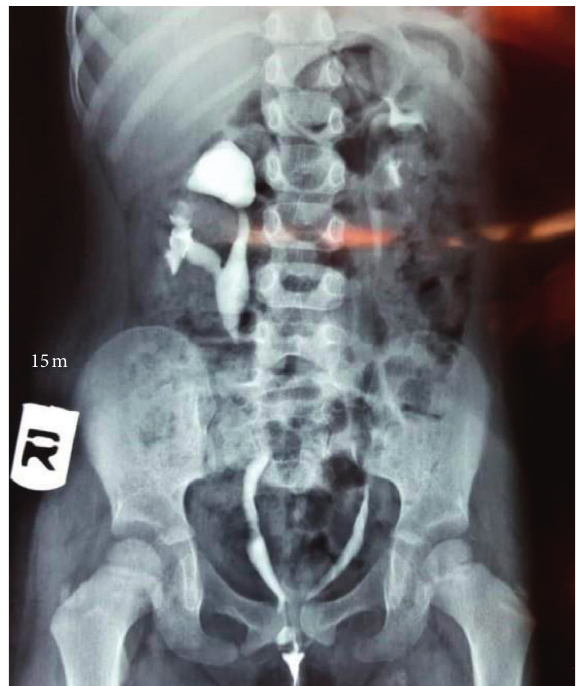
Figure 1: IVP with contrast showing agenesis of the bladder and ureters opening to the vagina.